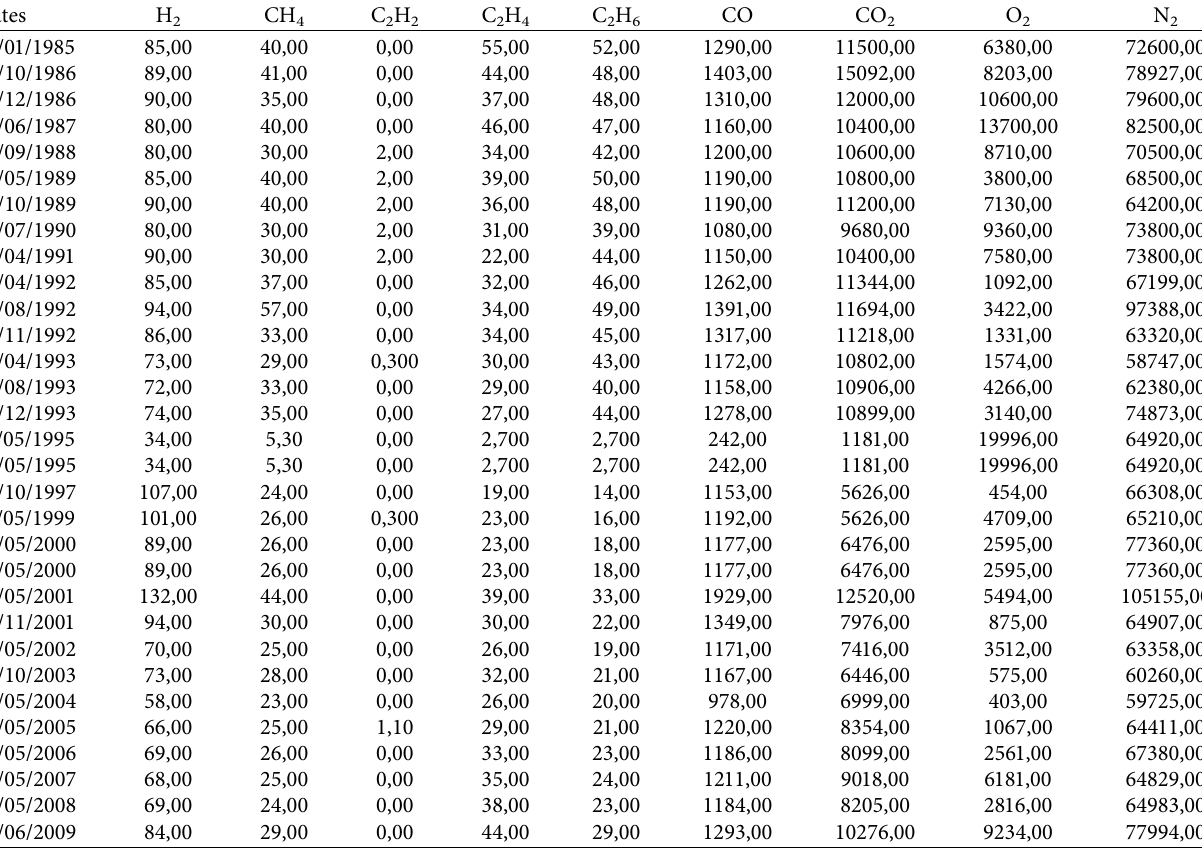
Table 6: Data completed after imputation by KNN.